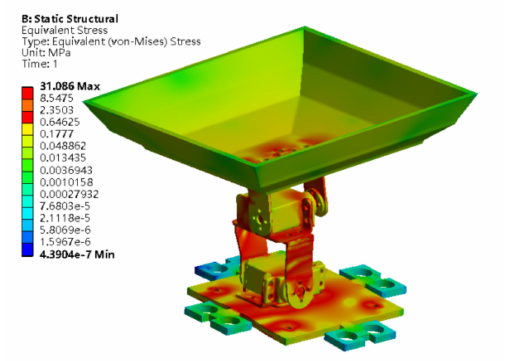
Figure 10. Stress